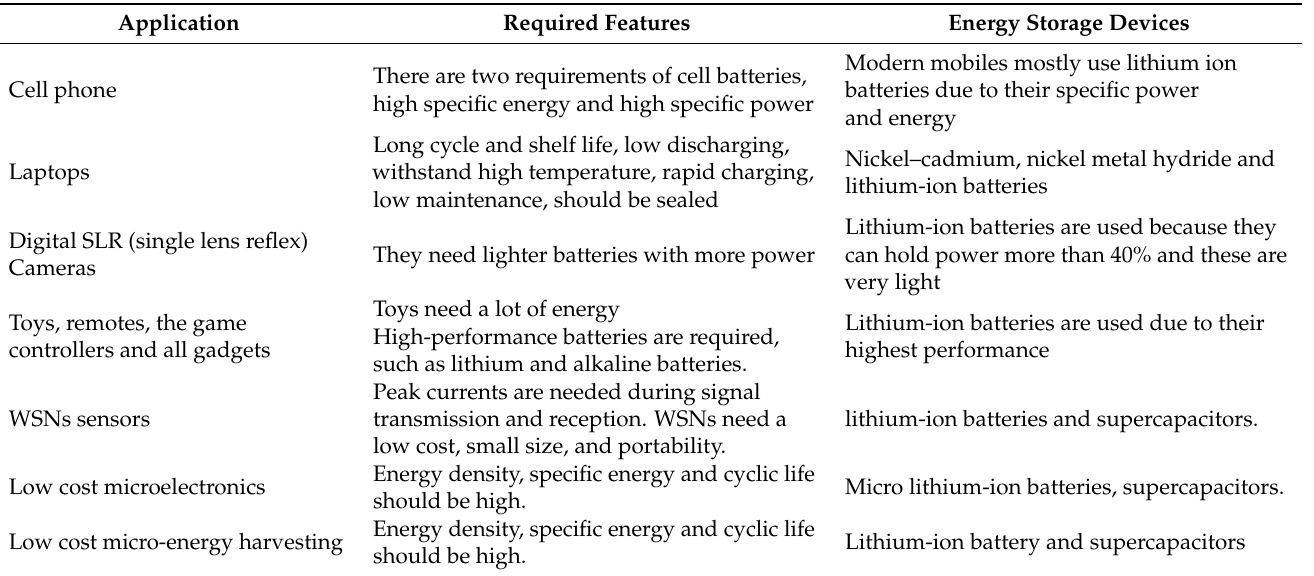
Table 6. Specific application and battery